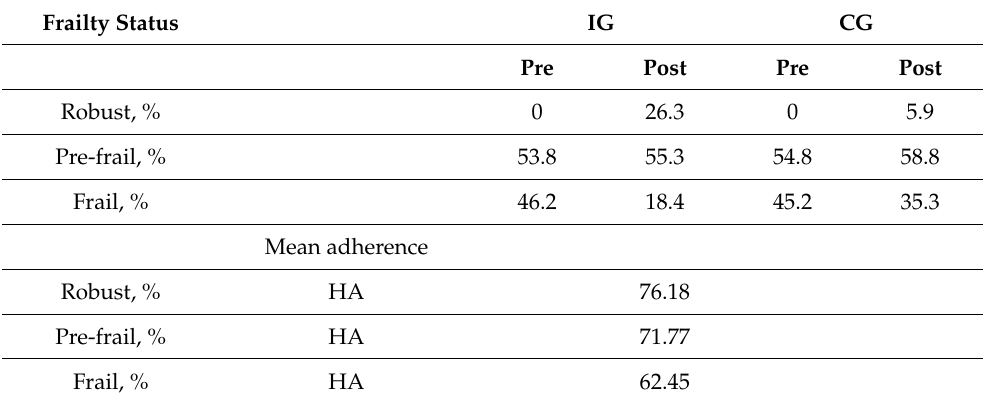
Table 3. Frailty status and adherence to PROMUFRA.